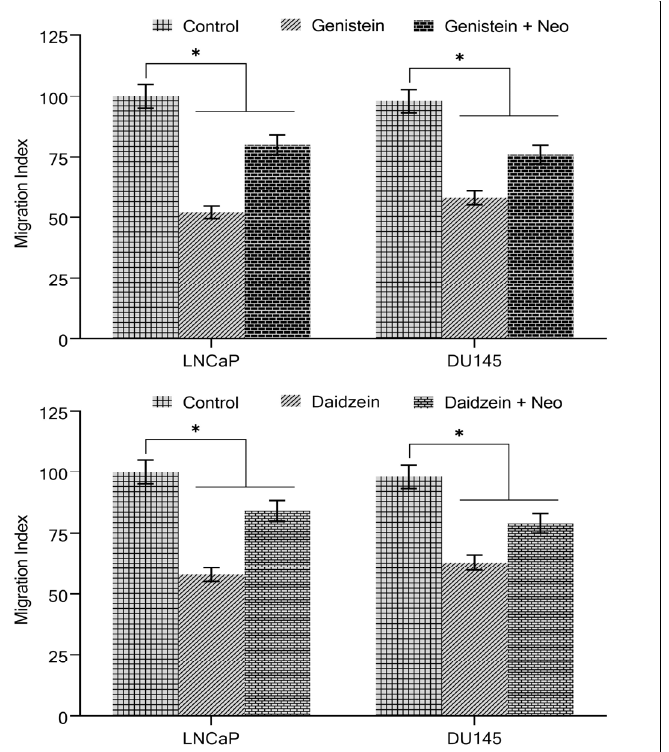
Figure 6. The effect of isoflavones on prostate cancer cell migration in the presence of the copper chelator neocuproine. The assay was carried out as described in Section 4. The cells were cultured with and without genistein/and daidzein (50 µM) and with or without neocuprione (50 µM). Values reported are mean ± S.E. of three independent experiments. * p value < 0.01 when compared to control.